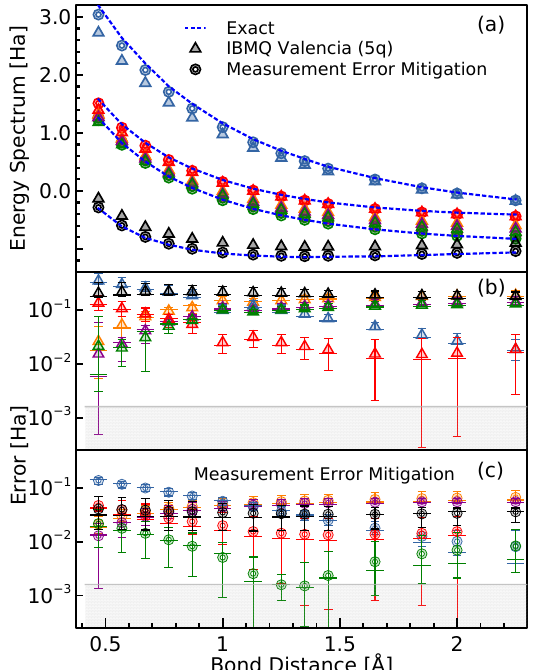
Figure 7. The complete hardware calculation using the IBMQ Valencia 5-qubit device. The lowest value shown in ( a ) for 5 distinct hardware runs where 8000 shots is used. The absolute error between exact and hardware results is shown in ( b ), where symbol indicates the mean and error-bars min/max amongst the 5 runs. ( c ) The same as ( b ) but with measurement error mitigation for the target hardware. The semi-opaque region in ( b ), ( c ) indicates chemical accuracy